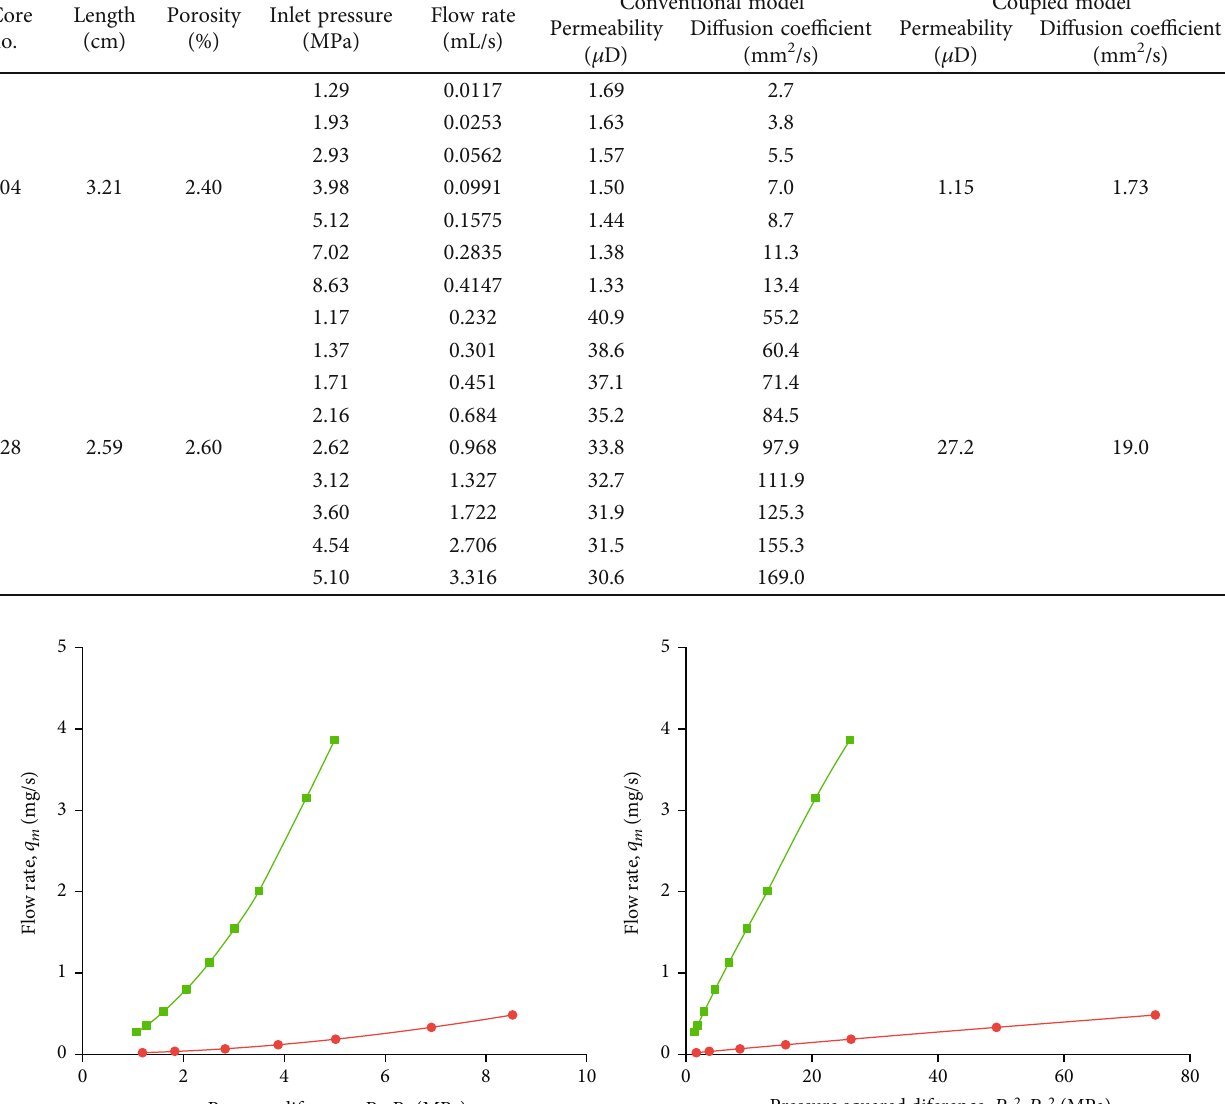
Table 1: Results of experimental analysis for shale coupled fl ow.